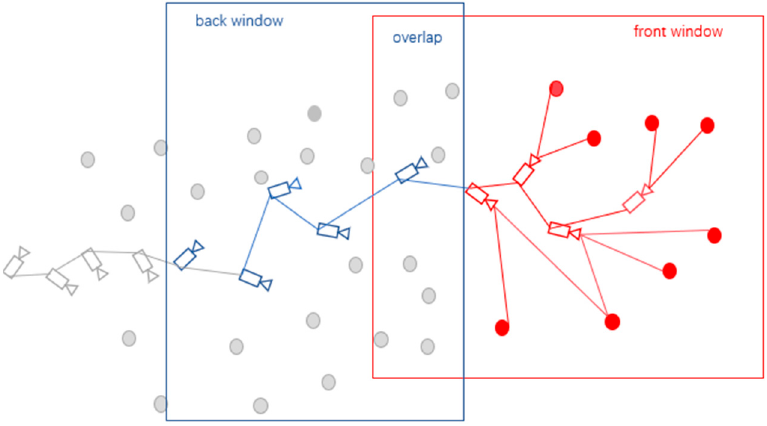
Figure 11. Front window and back window.